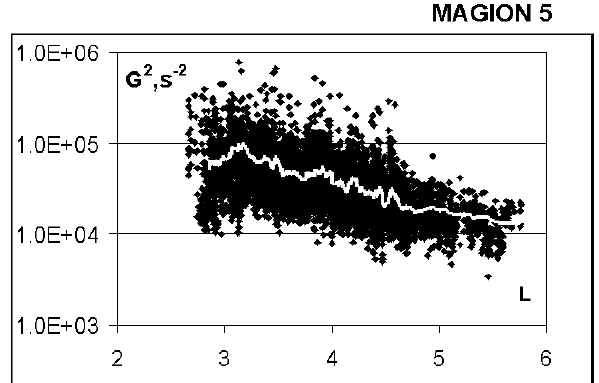
Fig. 6. The reduced sweep rate G 2 as a function of L-shell. The solid line shows the running average over 100 points of G 2 . The mean G(L) varies within a small interval 100–300s − 1 .